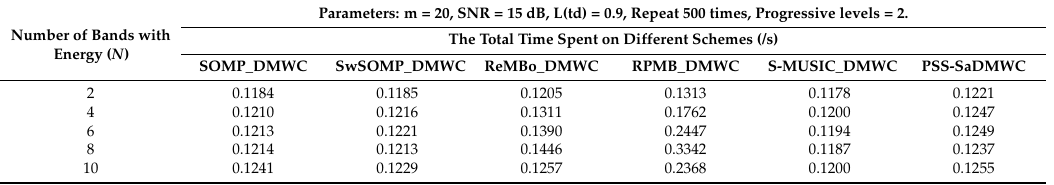
Table 7. The total time spent on different schemes with different N